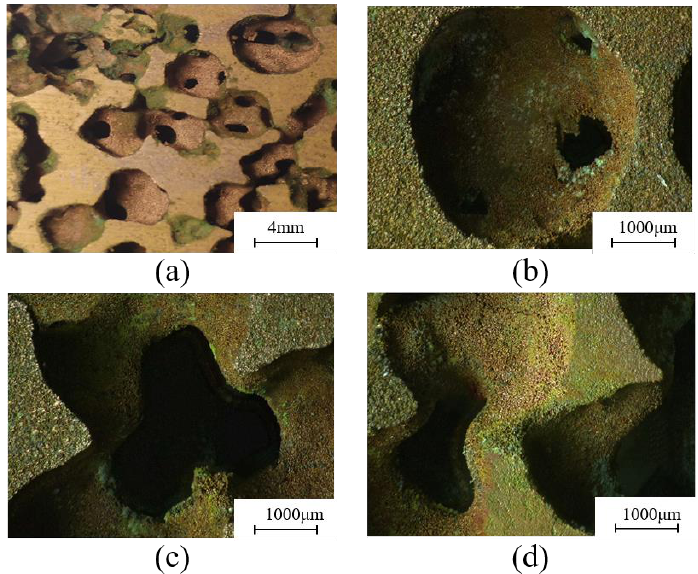
Figure 5. Microscope and metallographic features. ( a ) Macroscopic photos of open-cell copper foam surface, ( b ) Pores formed by two CaCl 2 particles, ( c ) Pores formed by three CaCl 2 particles, ( d ) Pores formed by multiple CaCl 2 particles.